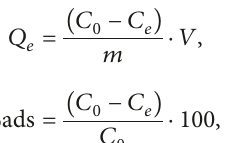
16 H 8 N 2 Na 2 O 8 S 2